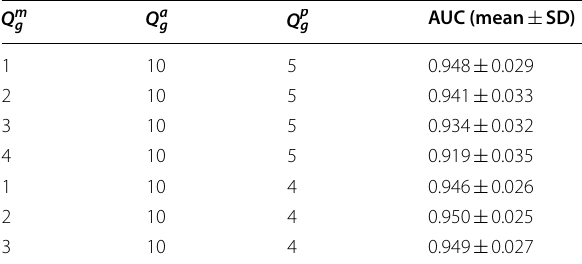
Table 6 AUC scores of TGV (or T of gradient magnitude, gradient azimuth and gradient polar angle where t -th root is set to be 2 Q m g